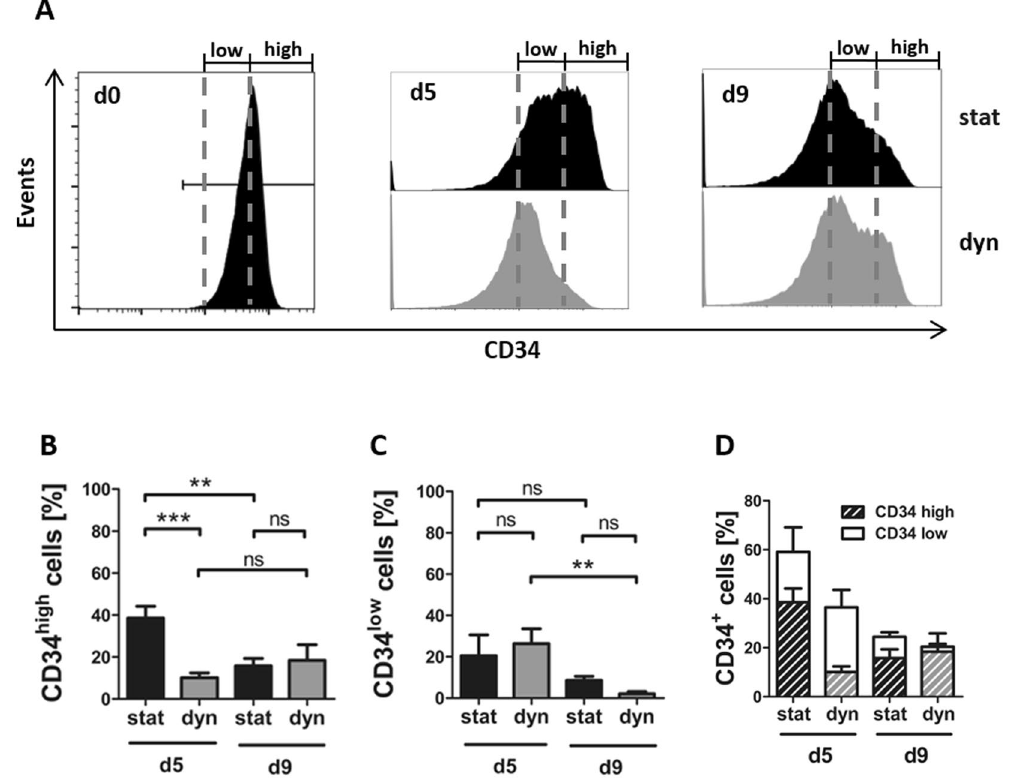
Figure 3. Static culture preserves a greater pool of CD34 high cells compared to dynamic culture in the early phase of culture. Comparison of percentages of CD34 high and CD34 low cells obtained from static and dynamic culture on day 5 and day 9. ( A ) Representative flow cytometry plots of CD34 expression analysis. Mode of culture is given on the right, the gates determining CD34 low and CD34 high cells are given on top. ( B ) Percentages of CD34 high and ( C ) CD34 low cells as assessed by flow cytometry. ( D ) Stacked column chart showing the percentage of CD34 + cells within the harvested cells subdivided into the percentages of CD34 low and CD34 high cells. White bars give the percentage of CD34 low cells, striped bars the percentage of CD34 high cells. ( A–D ) N = 4 independent